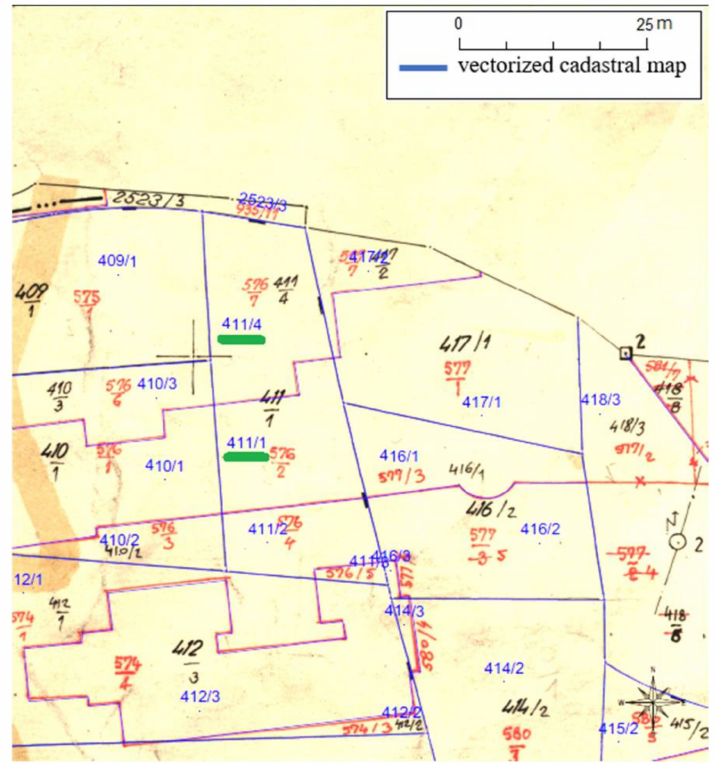
Figure 9. Example of maintenance-caused area inconsistency. Source: own